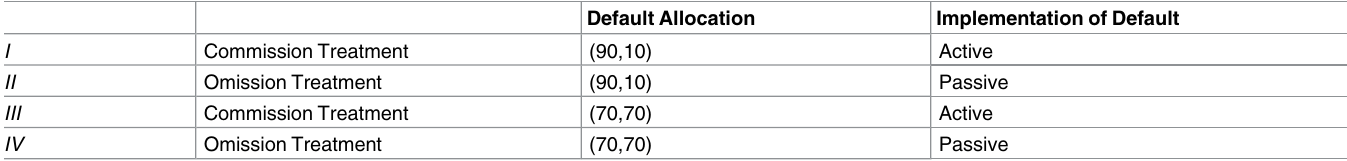
Table 1. Overview of treatments in Experiment 1: Choice between (90,10) and